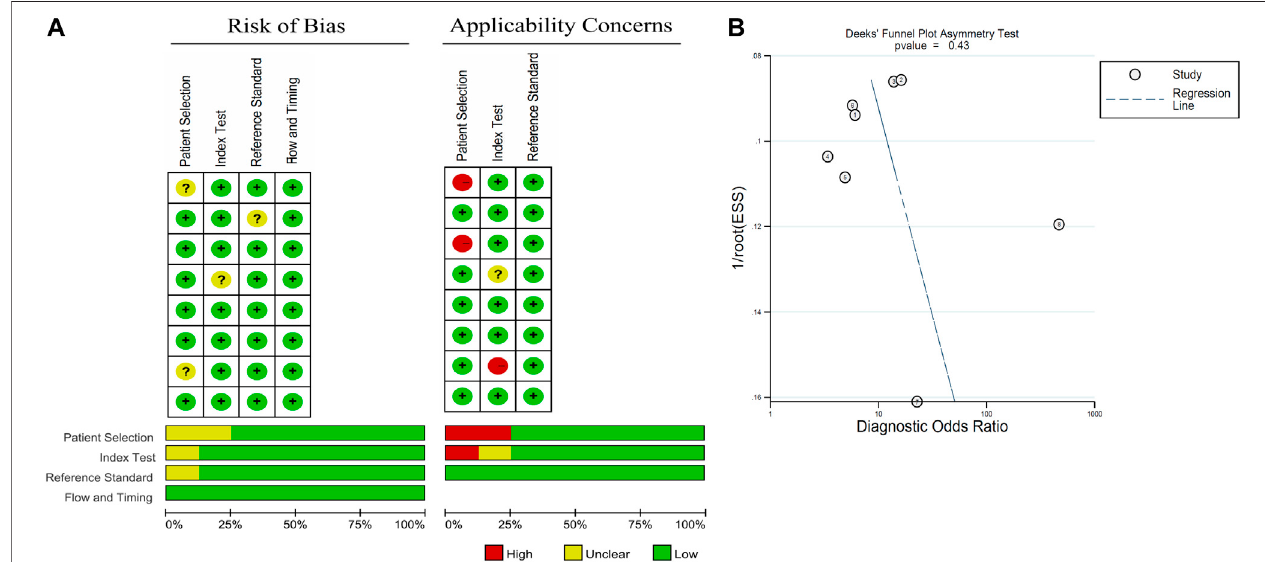
FIGURE 2| Graphical overview ofthe overall risk ofbias and applicability judgements for the 8 studies included according to the Quality Assessmentof Diagnostic Accuracy Studies (QUADAS) 2 tool and Deek ’ s funnel plot.